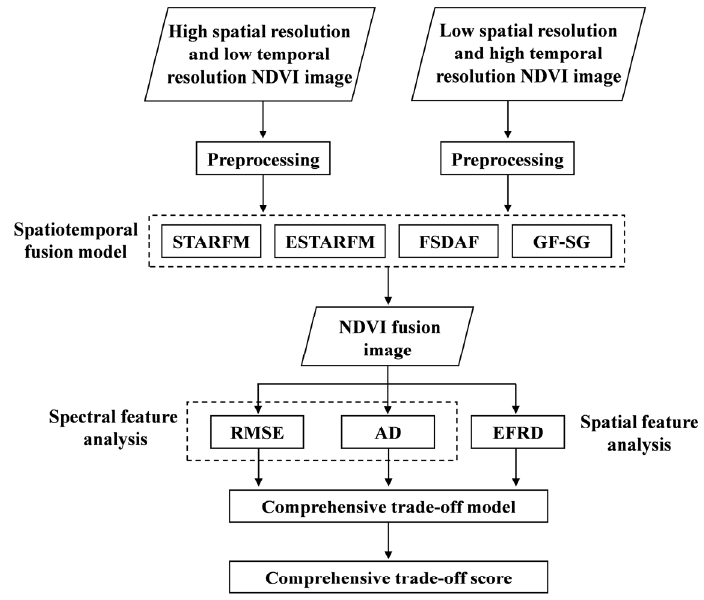
Figure 3. The flowchart of this